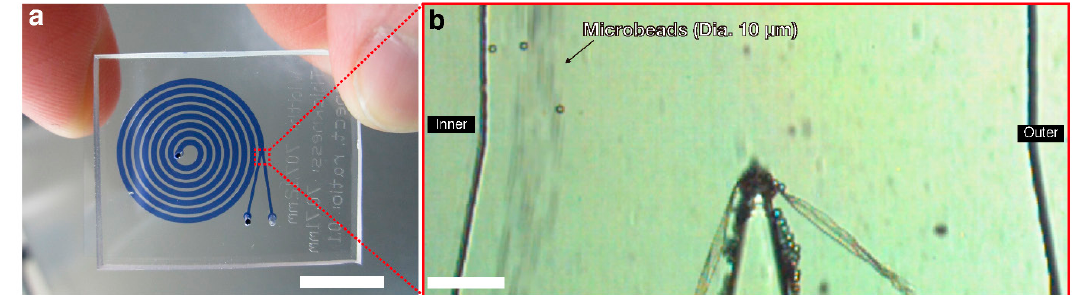
Figure 1. A spiral microfluidic device. ( a ) Photograph of a spiral microfluidic device; scale bar, 10 mm. Microchannels are highlighted by Trypan blue dye solution. Channel width and height are 707 and 70.7 µ m, respectively. Distance between two adjacent microchannels is 303 µ m; ( b ) A magnified micrograph of part of a spiral microchannel, enclosed by the red dotted box in Figure 1a; scale bar, 100 µ m. Ten-fold diluted microbeads (10 µ m diameter) in phosphate buffered saline were focused at an equilibrium position close to the inner wall of the microchannel.